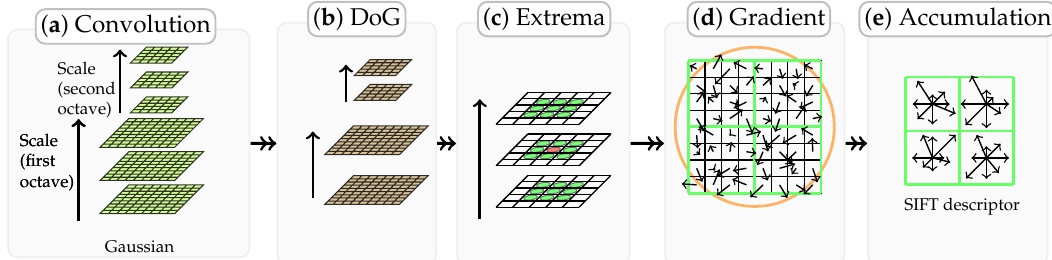
Figure 2. Illustration of how the SIFT feature descriptor is obtained. ( a ): Repeatedly convolving initial image with Gaussians to produce the set of scale space images. ( b ): Subtracting adjacent Gaussian images to produce the difference-of-Gaussian images. ( c ): Extrema detection by comparing a pixel (marked with red circle) to its 26 neighbors in 3 × 3 regions at the current and adjacent scales (marked with green circles). ( d ): Feature descriptor creation by computing the gradient magnitude and orientation at each image sample point. a Gaussian window indicated by the overlaid circle is used as weighting. ( e ) Orientation histograms accumulation by summarizing the contents over 4 × 4 subregions (a 2 × 2 subregions is shown for convenience), with the length of each arrow corresponding to the sum of the gradient magnitudes near that direction within the region, generating 4 × 4 × 8 descriptors, where 8 is the number of